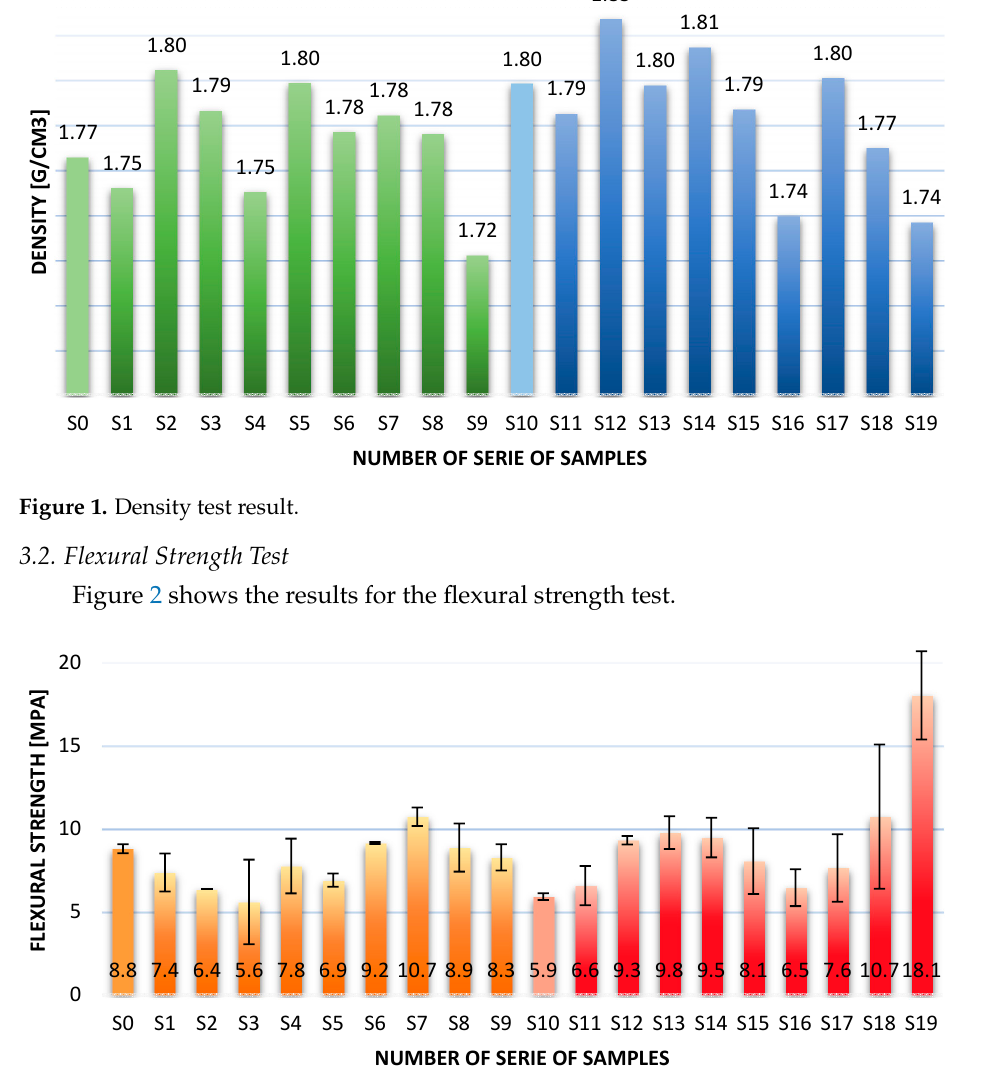
Figure 2. Results of the flexural strength test for geopolymer composites. Measurements of the bending strength in the case of composites consisting of metakaolin and sand, in each variant of the addition of fibers, show the increase in strength in relation to the samples without additives. The measurements presented show that the highest values were obtained for the metakaolin-based composites with the addition of aramid roving. The highest bending strength is demonstrated by composites with 2% aramid fibers—18.1 MPa. The lowest strength was achieved by geopolymer samples containing 2% of carbon fiber—6.5 MPa. The surprising result of the research is that the results for the metakaolin matrix and sand for the glass fiber are higher than those for the composites